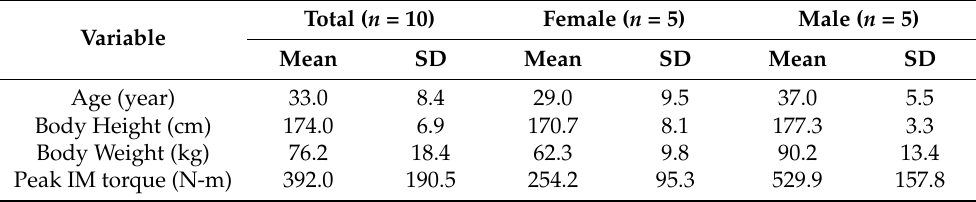
Table 1. Participant demographic characteristics and lumbar extension torque values.